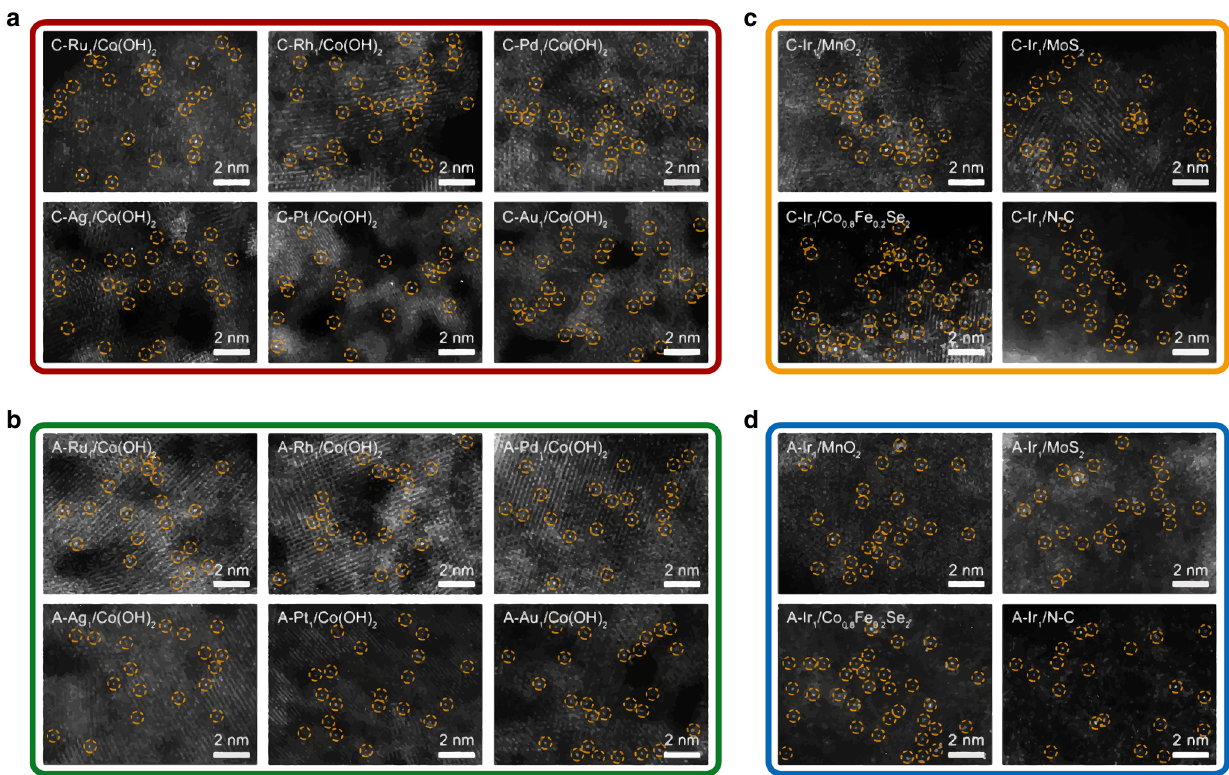
Fig. 3 Generality of electrochemical deposition for synthesizing SACs. a , b Cathodically ( a ) and anodically ( b ) deposited metal single atoms on Co(OH) 2 nanosheets (denoted as C-M 1 /Co(OH) 2 and A-M 1 /Co(OH) 2 , M = Ru, Rh, Pd, Ag, Pt, and Au). c , d Cathodically ( c ) and anodically ( d ) deposited Ir single atoms on different supports (denoted as C-Ir 1 /support and A-Ir 1 /support, support = MnO 2 , MoS 2 , Co 0.8 Fe 0.2 Se 2 , and N-C). The depositions were all conducted in a 1 M KOH electrolyte containing 100 μ M metal precursors. For cathodic deposition, the deposition process was conducted in a potential range from 0.10 to − 0.40 V for ten scanning cycles. For anodic deposition, the deposition process was conducted in a potential range from 1.10 to 1.80 V for three scanning cycles. The singly dispersed metal atoms are marked by yellow